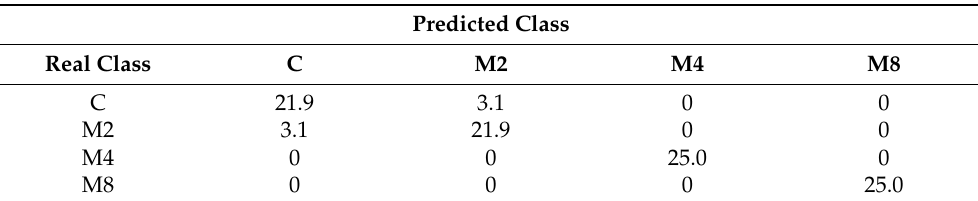
Table 3. Confusion matrix obtained through PLS-DA for discrimination between stuffed olives with flavoured hydrocolloids. Values are expressed in percentage.